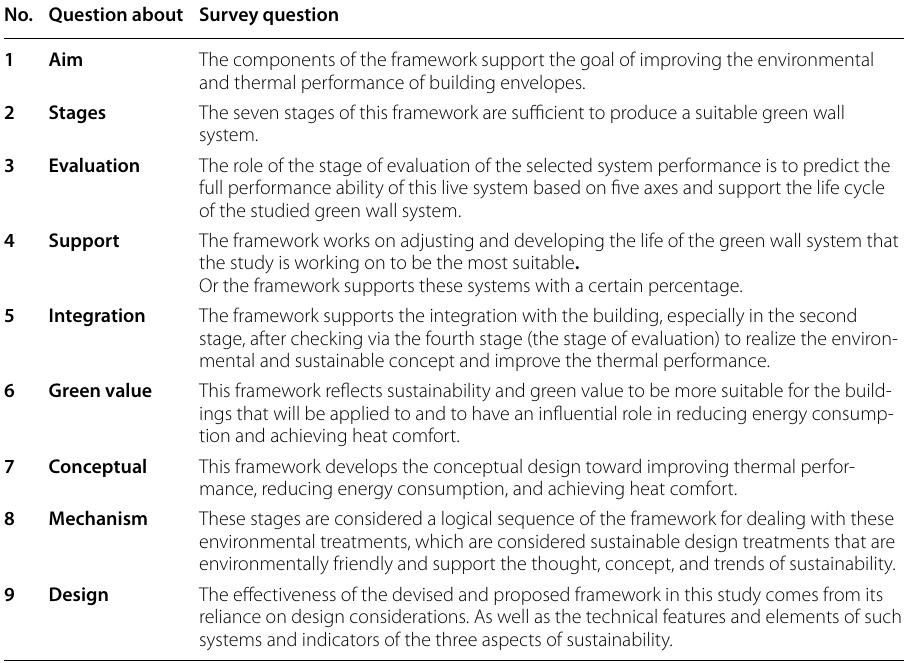
Table 6 Questionnaire questions were relied on in the survey study No. Question about Survey